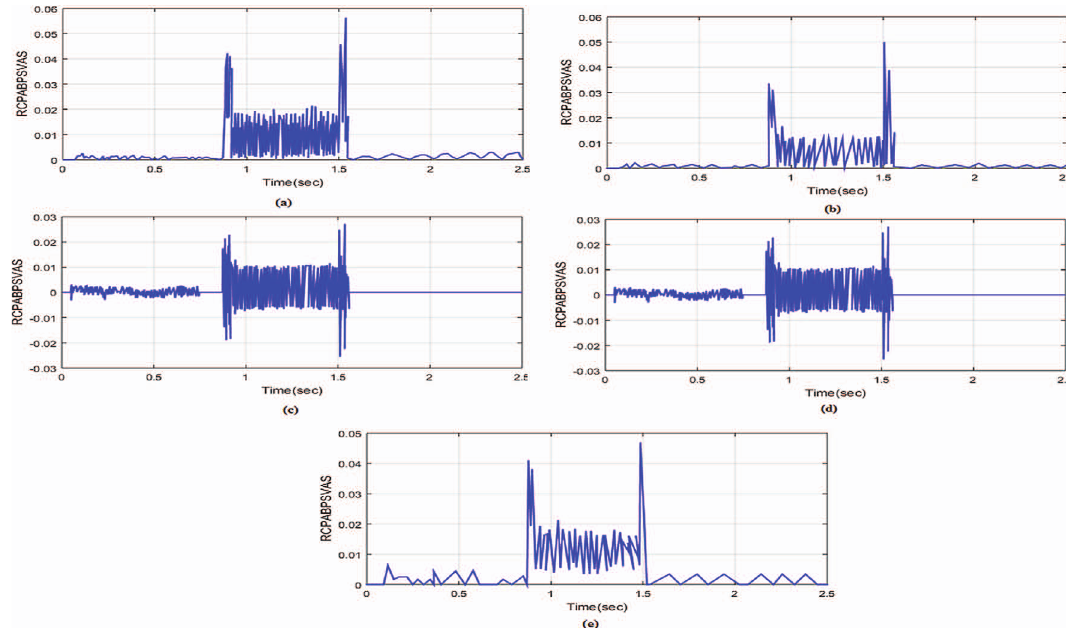
Fig. 16. System performance during capacitor switching. Table 1. Detection of islanding in a variety of case studies. S. No